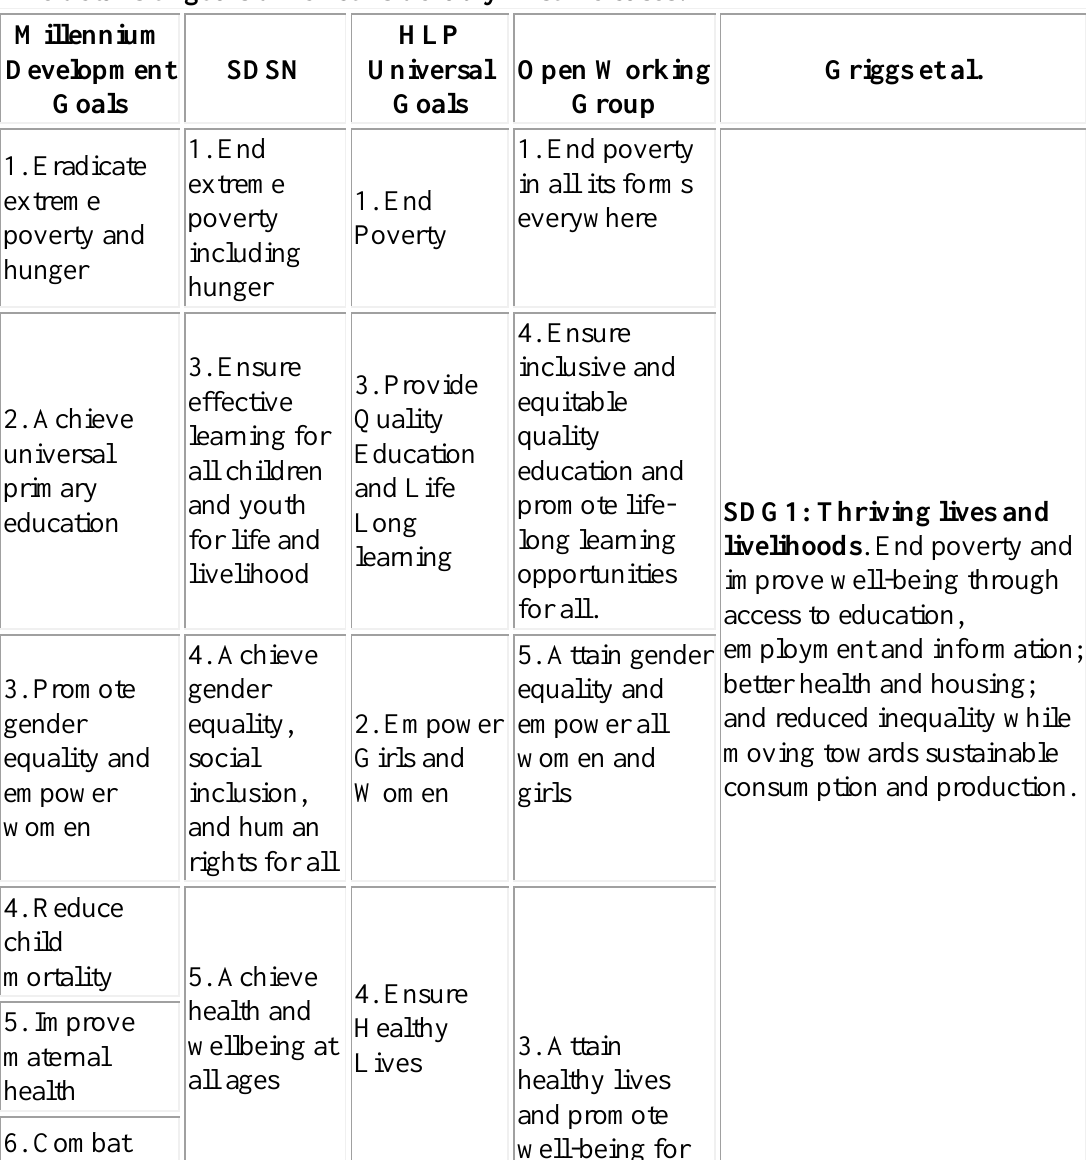
Table A1: A comparison of the approximate scope of different goal formulations: the Millennium Development Goals (MDGs), the UN Sustainable Development Solutions Network (11) and High Level Panel (HLP) (12) proposals, the OWG (2014) and the Sustainable Development Goals as proposed by Griggs et al. (10). The details of goals differ considerably in some